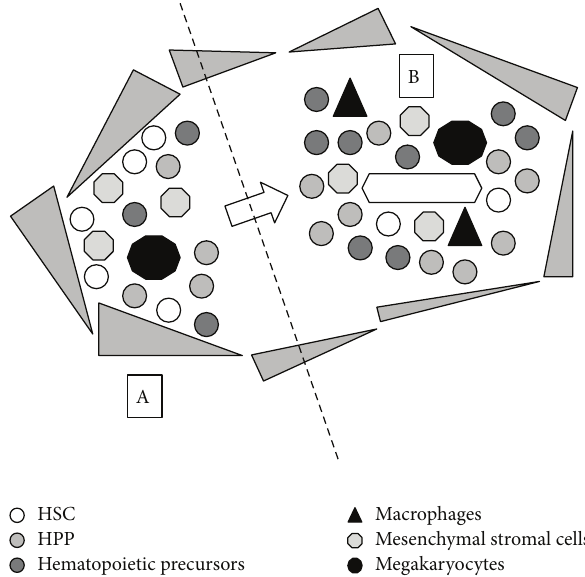
Figure 3: Simplified schematics of the endosteal and vascular hematopoietic niches. Two hematopoietic niches have been iden- tified in the bone marrow, even though their nature as anatomical ratherthanfunctionalentitiesisstillamatterofdebate.Thefirstone, called the “endosteal niche” (A), is located near the endosteum and thought to harbour mainly quiescent HSC capable of extensive self- renewal. It is thought to be composed of osteoblasts (represented as a layer of “grey triangles” in the figure), mesenchymal stromal cells (“grey octagons”), megakaryocytes (“black decagons”), HSC (“white circles”), early committed HPP (“light grey circles”), and hematopoietic precursors at various degrees of commitment (“dark grey circles”). The second one, called the “vascular niche” (B), is located around the central vessel in the bone marrow and seems to harbour mainly rapidly proliferating HSC and HPP. It is composed by endothelial cells (boarding the central vessel), mesenchymal stromal cells (“grey octagons”), HSC (“white circles”), HPP (“light grey circles”), hematopoietic precursors at various degrees of commitment (“dark grey circles”), macrophages (“black triangles”), and megakaryocytes (“black decagons”). According to a theory, HSC would move from the endosteal to the vascular niche as they switch from a “resting” to a “proliferating”